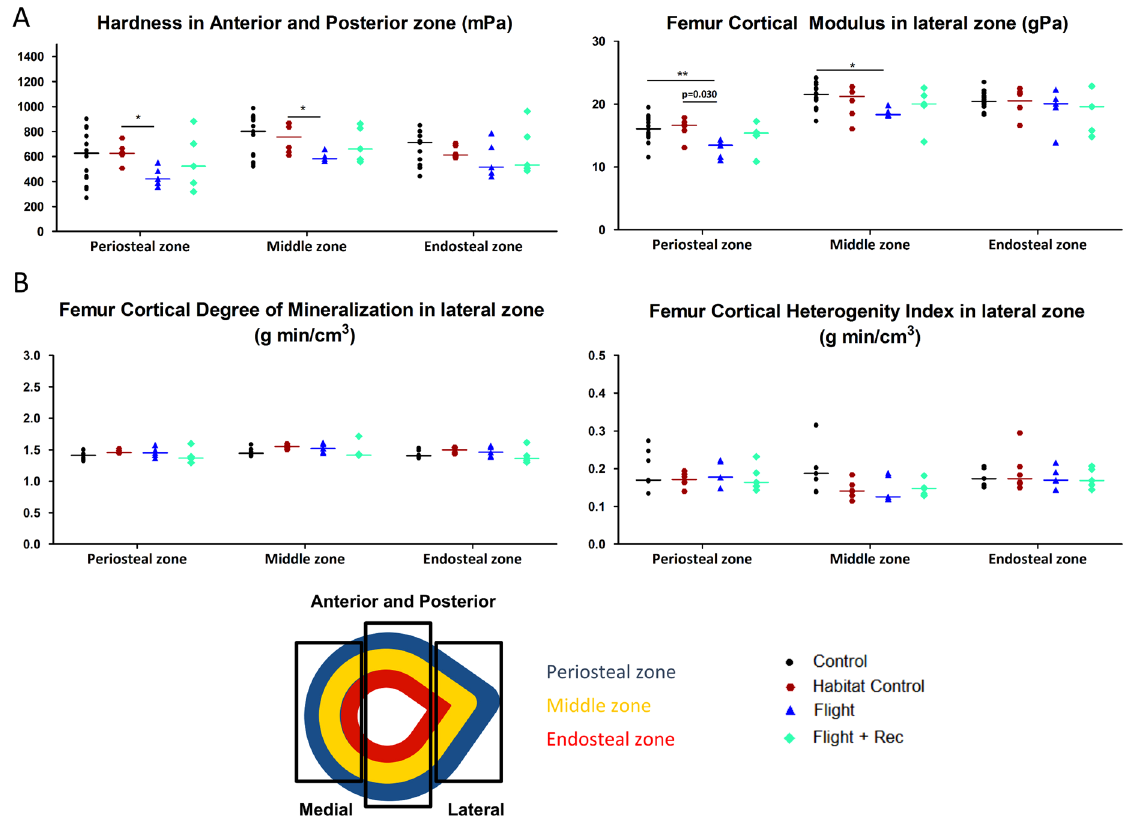
Figure 6. Effects of spacecraft housing conditions, spaceflight and recovery on ( A ) femur cortical biomechanical properties, ( B ) femur cortical mineralization parameters in the lateral zone (schema in the upper right corner illustrates the regions of analysis), and ( C ) cortical FTIRM parameters. Data are presented as clusters of individual points (bars = median). * p < 0.017, ** p <